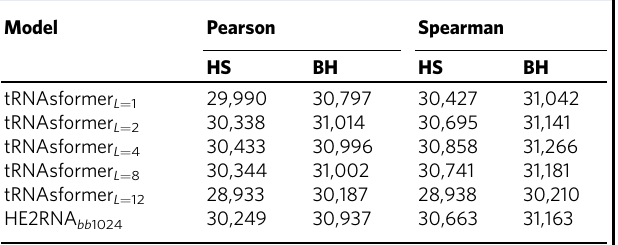
Table 1 The number of genes was predicted with a statistically signi fi cant correlation ( p -value < 0.01) under HS and BH correction.